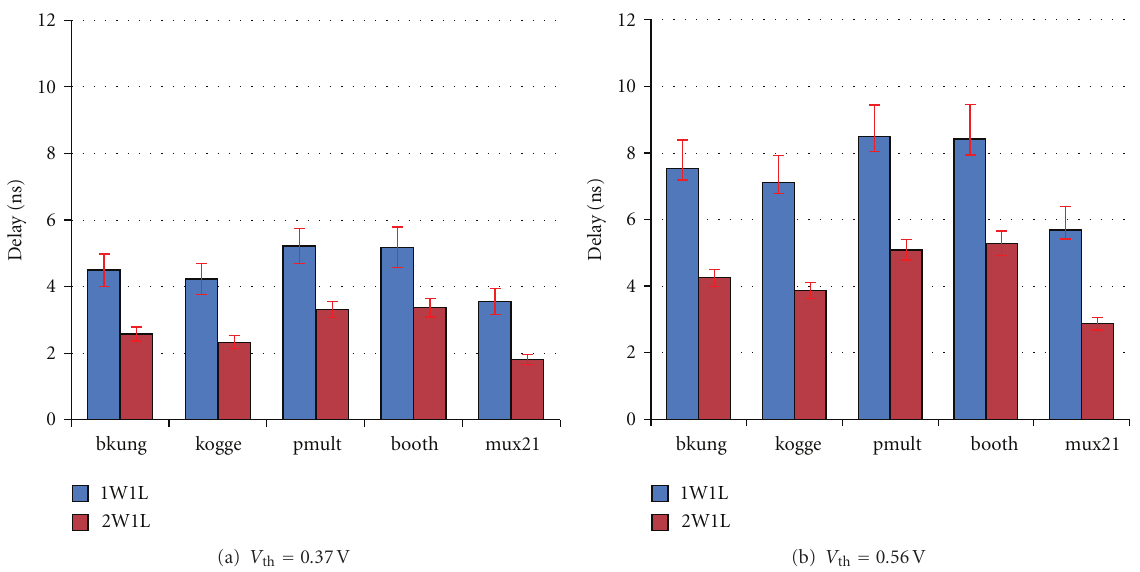
Figure 8: Delay characterization of function units with multi- V th /V dd and variation